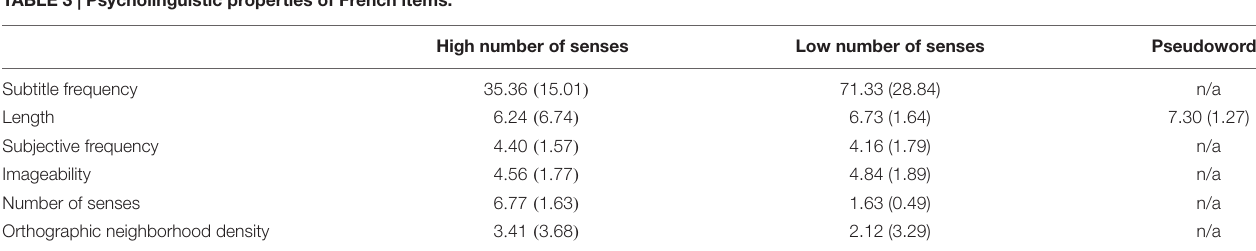
TABLE 3 | Psycholinguistic properties of French